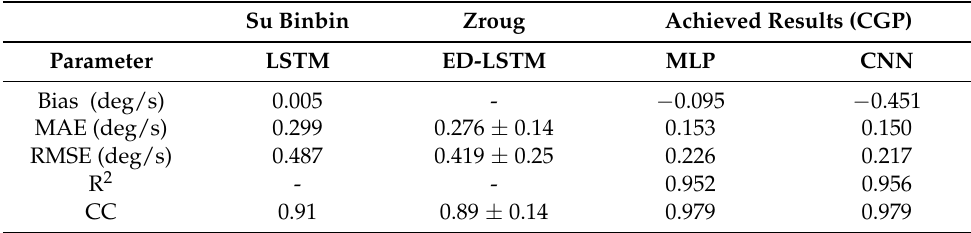
Table 6. Results Comparison.